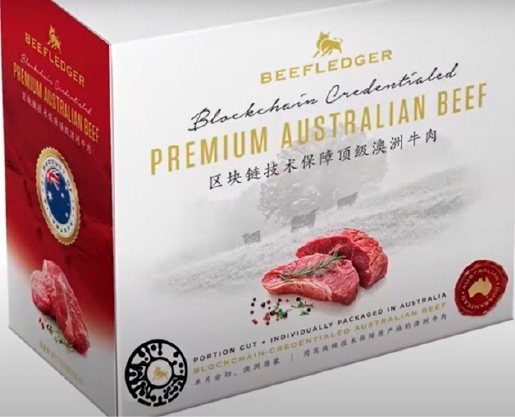
Figure 2. Beef package with a traceable fingerprint. Source: authors.